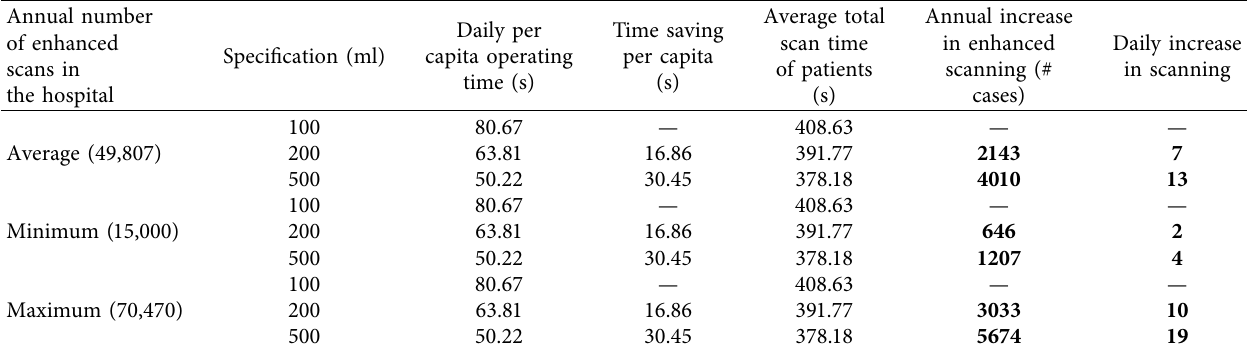
Table 4: Efect of diferent specifcations of contrast agents on hospital